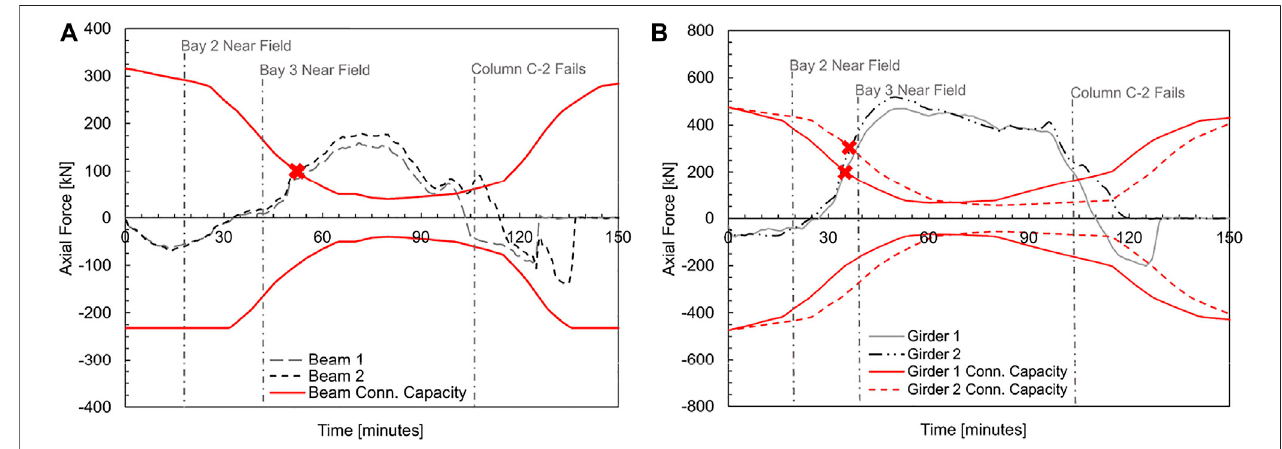
FIGURE 16 | Axial force histories and connection capacities for (A) beams and (B) girders connecting to column C-2 for Fire Scenario #3.